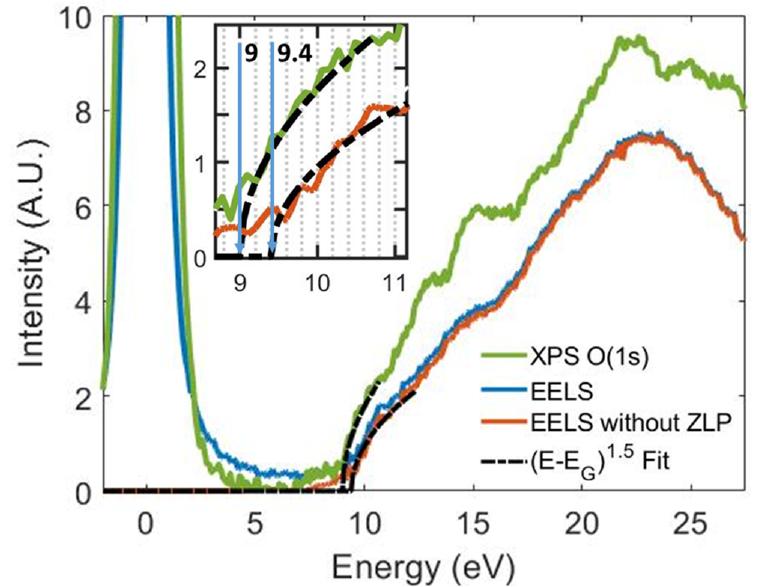
Figure 2. Scanning transmission electron microscopy—Valence energy loss spectroscopy (STEM- VEELS) spectrum measured on the 40 nm SiO 2 lamella represented as recorded (in blue) and with the zero loss peak deconvoluted (in red). The O(1s) X-ray photoelectron spectroscopy—photoelectron energy loss spectroscopy (XPS-PEELS) spectrum recorded on the 40 nm SiO 2 sample is represented in green with the O(1s) peak maximum as the energy origin. An ( E − E gap ) 1/2 curve is used to fit the band-gap edge of both spectra and is represented with a black discontinuous curve. The fitting of the spectra edge is represented as well in the inset of the figure, yielding a 9.4 ± 0.2 eV band-gap for the VEELS spectrum and 9.0 ± 0.2 eV for the PEELS